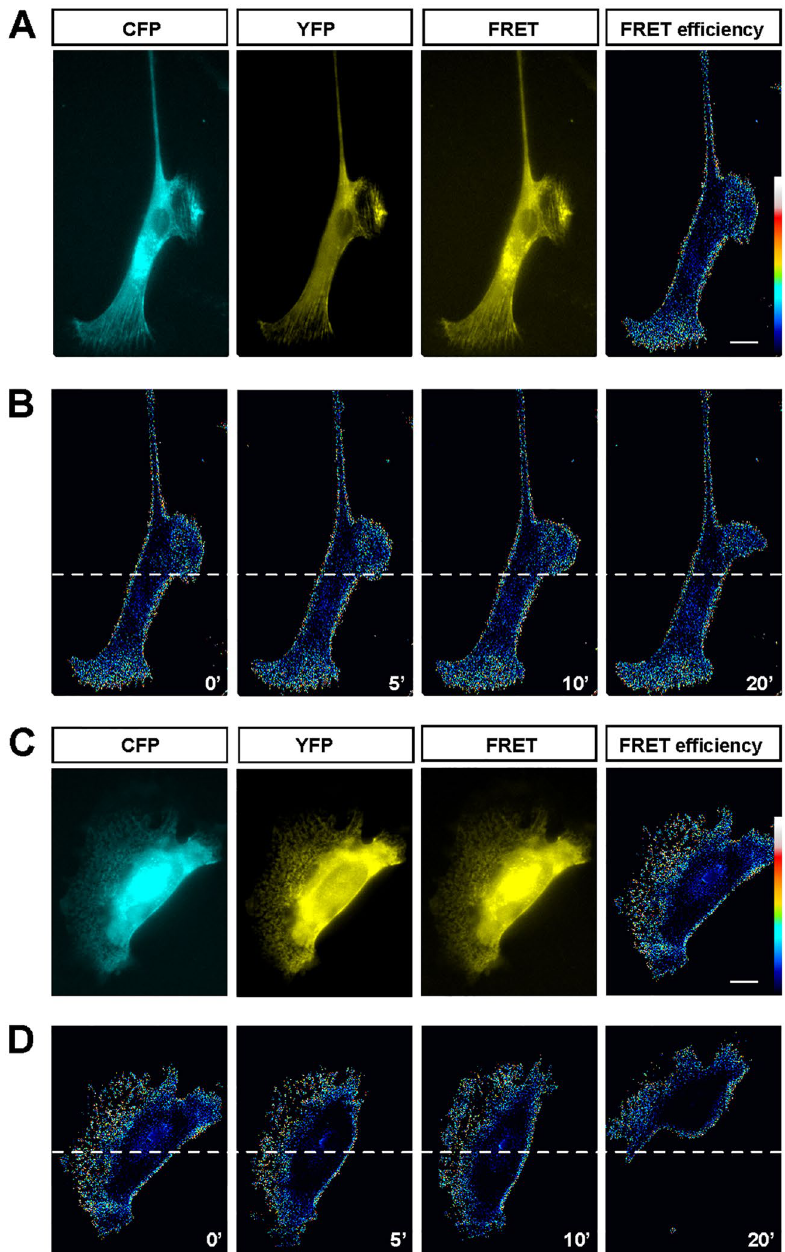
Figure 2. The distribution of active myosin II in migrating OECs. ( A ) Representative FRET images with three- channel microscopy showed the distribution of active myosin II in cultured Schwann-cell like OECs. ( B ) Images showed dynamic FRET signal (in pseudocolors) of active myosin II in the migrating Schwann-cell like OECs. ( C ) Representative FRET images with three-channel microscopy showed the distribution of active myosin II in cultured astrocyte-like OECs. ( D ) Images showed dynamic FRET signal (in pseudocolors) of active myosin II in the migrating astrocyte-like OECs. Scale bars, 20 μ m. Time,